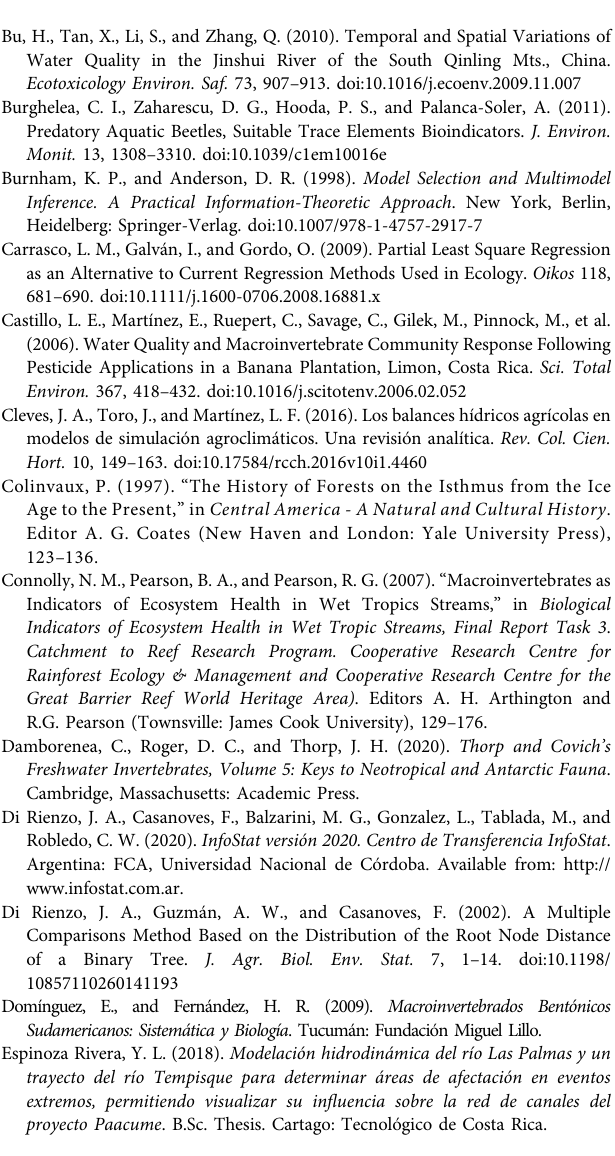
Supplementary Figure S1 | (A) Percentage abundances of the most common taxonomicgroupsatthethreedifferentsamplingareas. (B) Percentageabundances of the functional feeding groups (FFG) at the three different sampling areas. CG (cid:2) Collector-Gatherers,Ft (cid:2) Filterers,Pc (cid:2) Piercers,Pr (cid:2) Predators,Sc (cid:2) Scrapers,and Sh (cid:2)